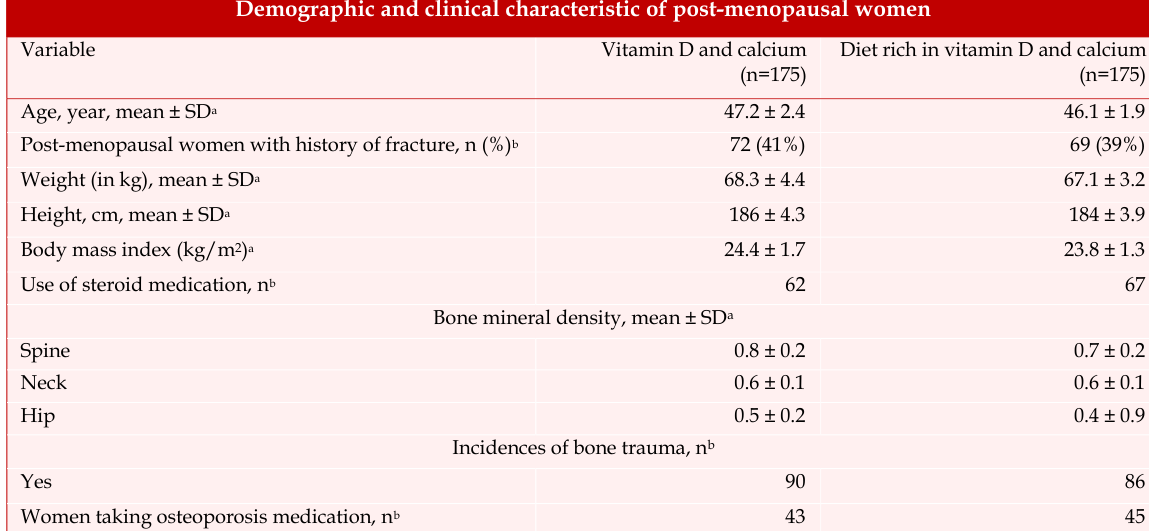
Demographic and clinical characteristic of post-menopausal women Variable Vitamin D and calcium